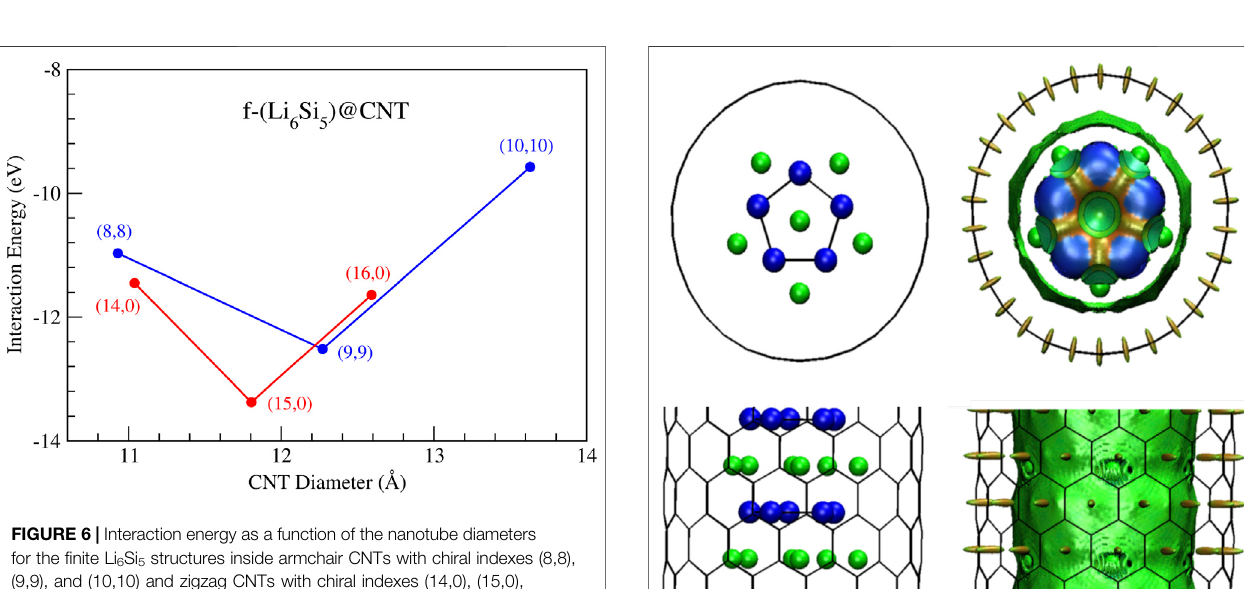
FIGURE5| Energyasafunctionoftimeformoleculardynamicsimulationsat500 Kforthe fi niteLi 6 Si 5 structure(f-Li 6 Si 5 ).Therightimagesshowtopandsideviews of a snapshot taken at 10,000 fs